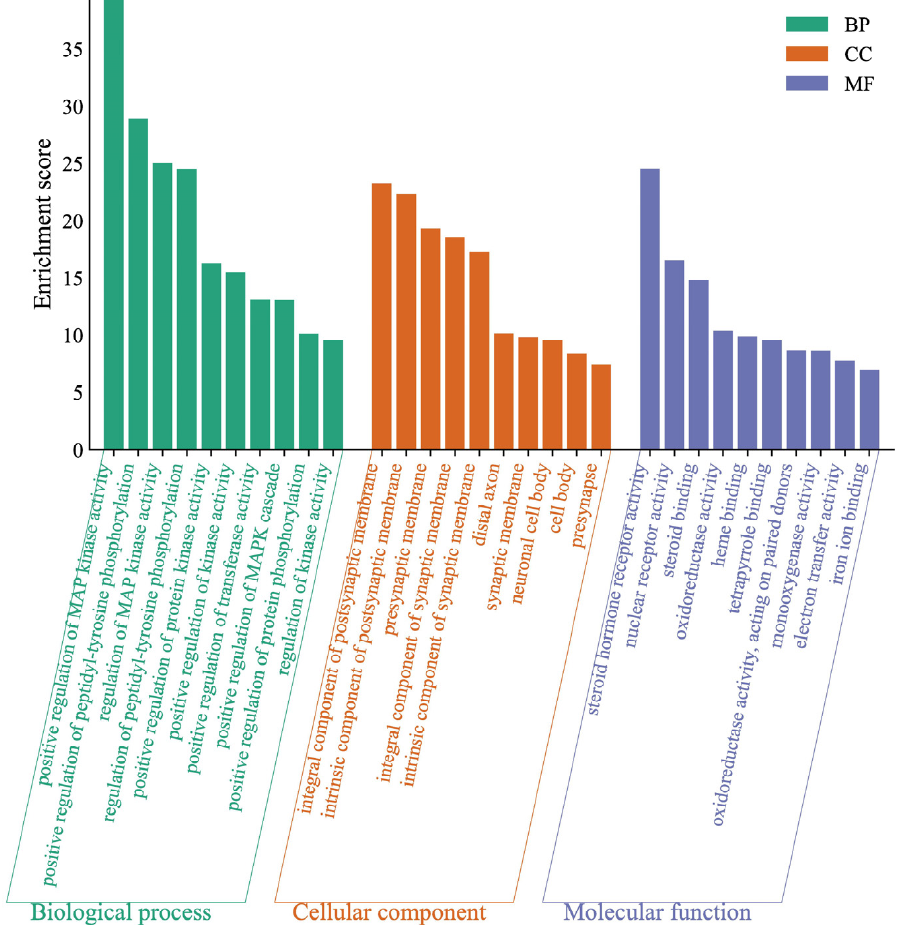
Figure 9. Gene Ontology (GO) enrichment analysis of the target proteins of neobavaisoflavone.